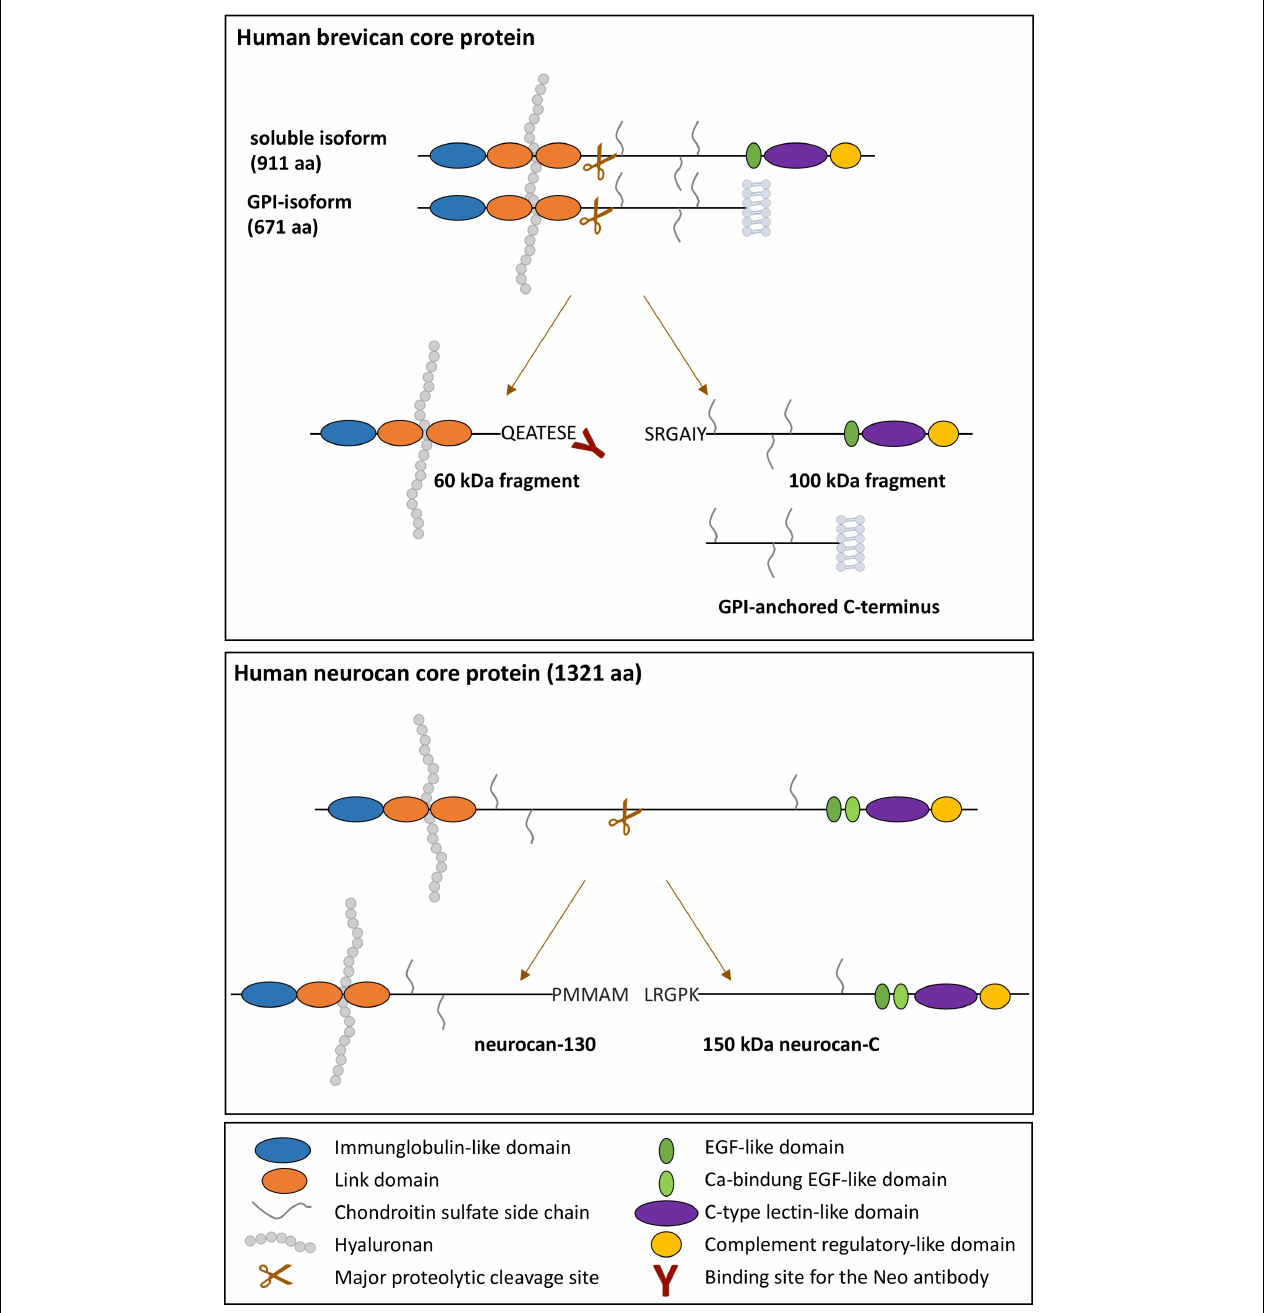
FIGURE 1 | Schematic illustration of the domain structure of human soluble and GPI-anchored brevican and neurocan and their major proteolytic fragments. Domains are color-coded. The hyaluronan-binding regions and the binding site of the neoepitope-specific brevican antibody are